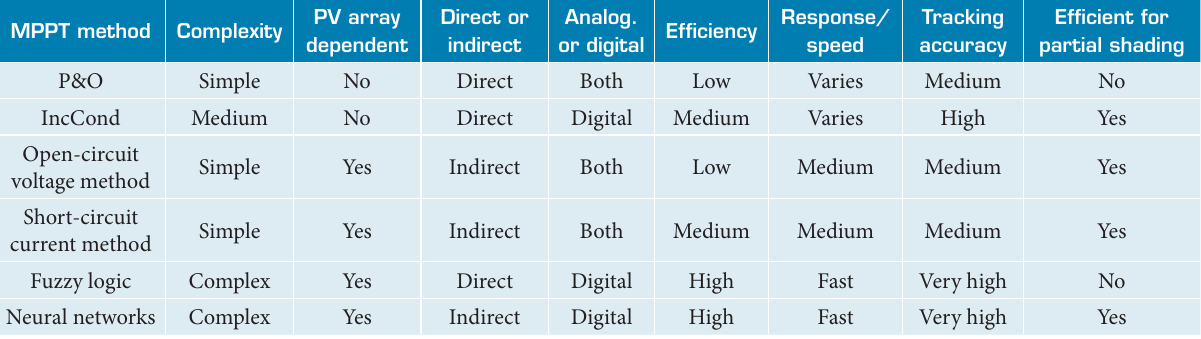
Table 1. Major characteristics of MPPT methods (Bhatnagar and Nema